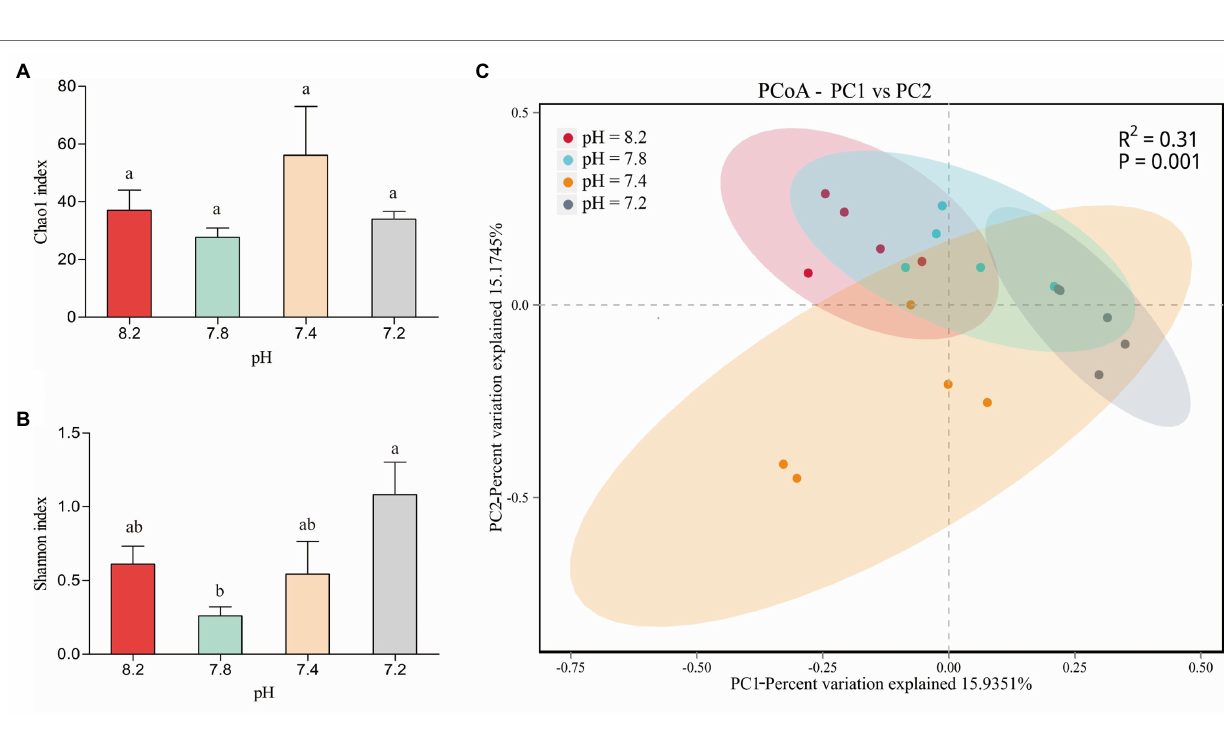
FIGURE 4 | (A) Chao1 diversity and (B) Shannon diversity indices values of Acropora valida -associated bacteria between different pH. The error bars are the mean ± SD. values (C) PCoA of the unweighted UniFrac distance matrix representing differences in community composition at the OTU level. Lower case letters (a, b, c) denote significant differences by Duncan post hoc